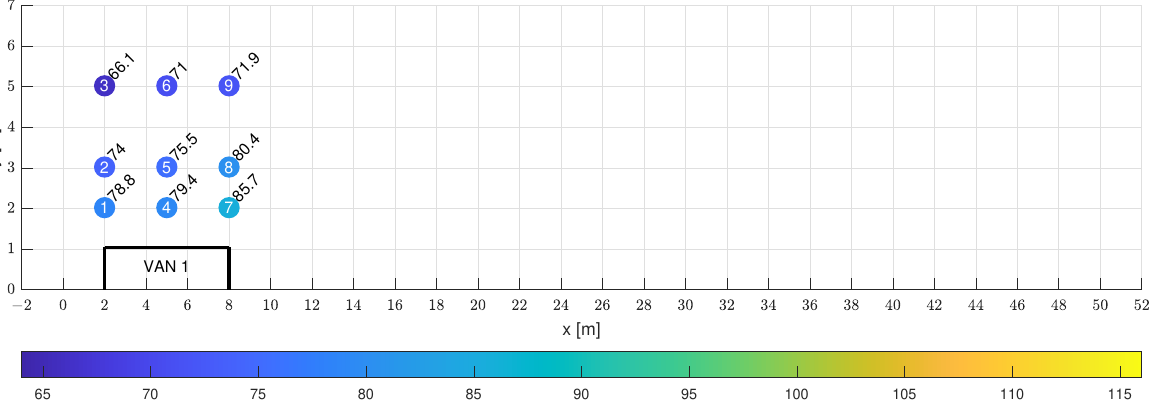
Figure 16. Overall sound pressure level in decibels (dB) on the side of the single van, measured at receivers for the z-coordinate of 1.7 m. View from the